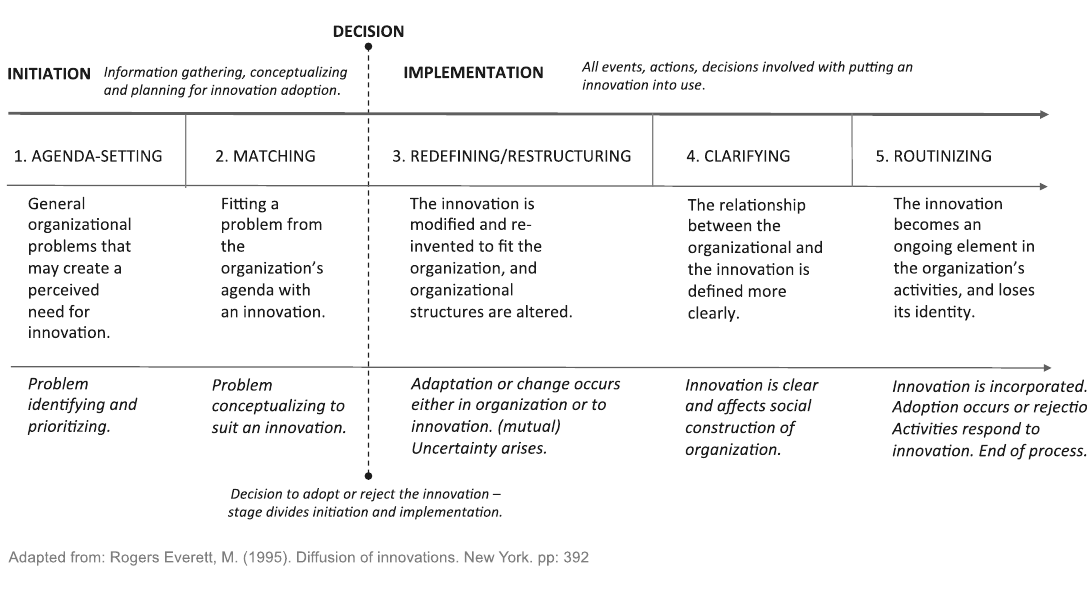
Fig. 2. Adaptation of E. Rogers’ five stages of the innovation process inside